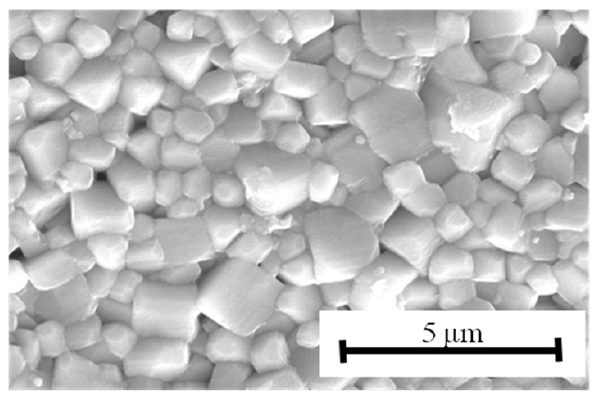
Figure 4. SEM micrograph of surface of multilayer KNN ‐ CZ ‐ 2 sample.